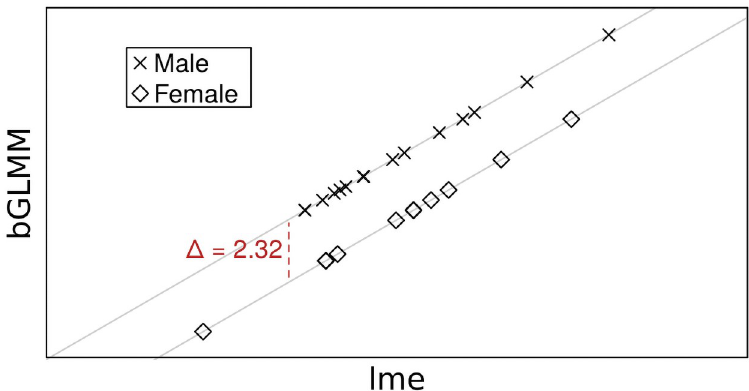
Fig 1. Comparison between random intercept estimates by lmer and bGLMM for